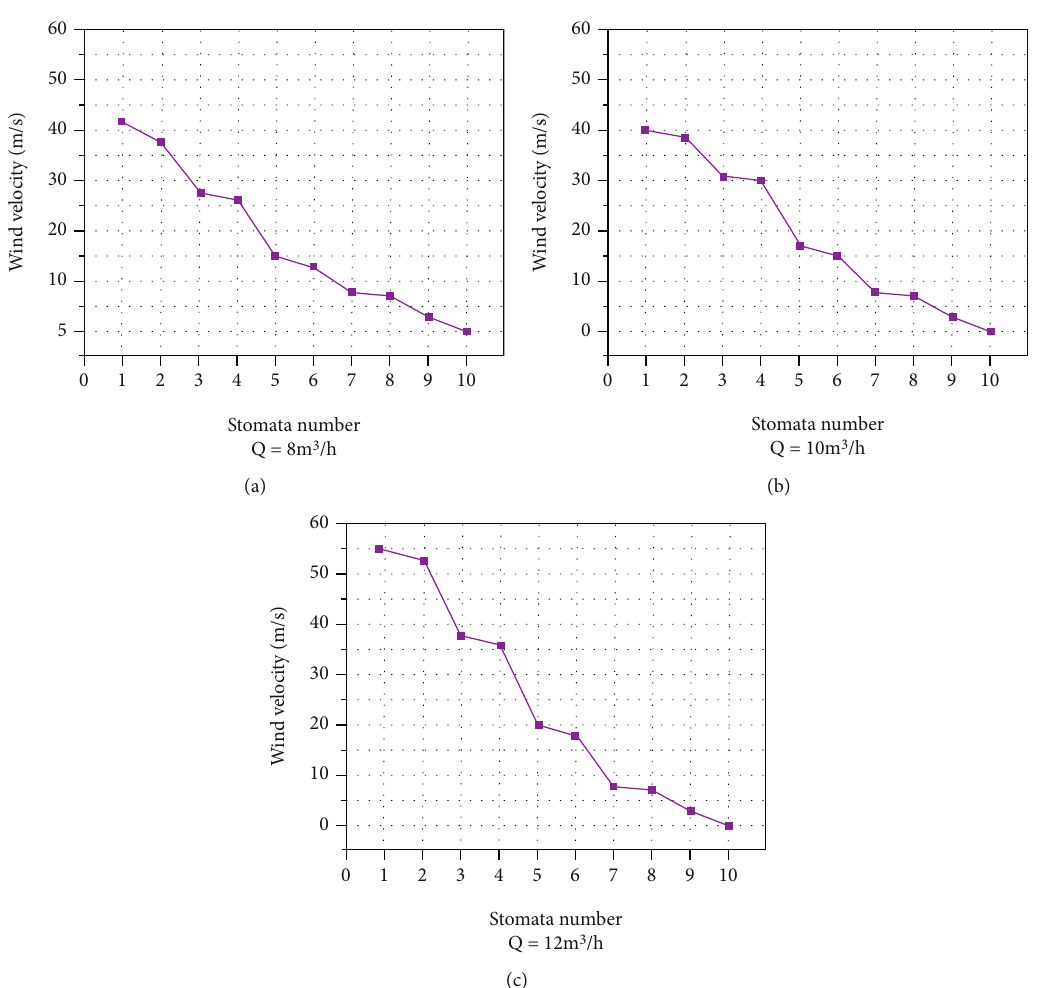
Figure 11: Stomatal wind speed fi gure of spiral type: (a) when the ventilation rate is 8m 3 /h, the wind speed of 10 representative pores on the pipeline; (b) when the ventilation rate is 10m 3 /h, the wind speed of 10 representative pores on the pipeline; (b) when the ventilation rate is 12m 3 /h, the wind speed of 10 representative pores on the pipeline.